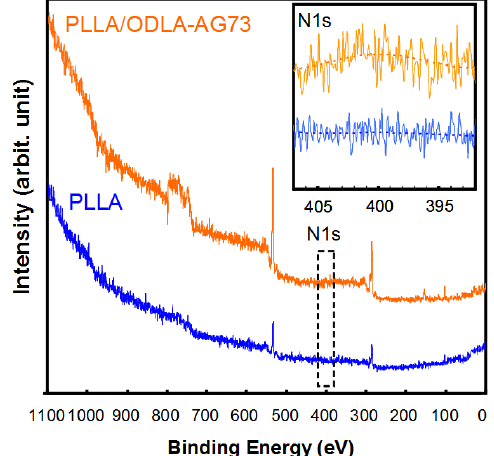
Figure 3. X-ray photoelectron spectroscopy (XPS) spectra of PLLA and PLLA/ODLA-AG73